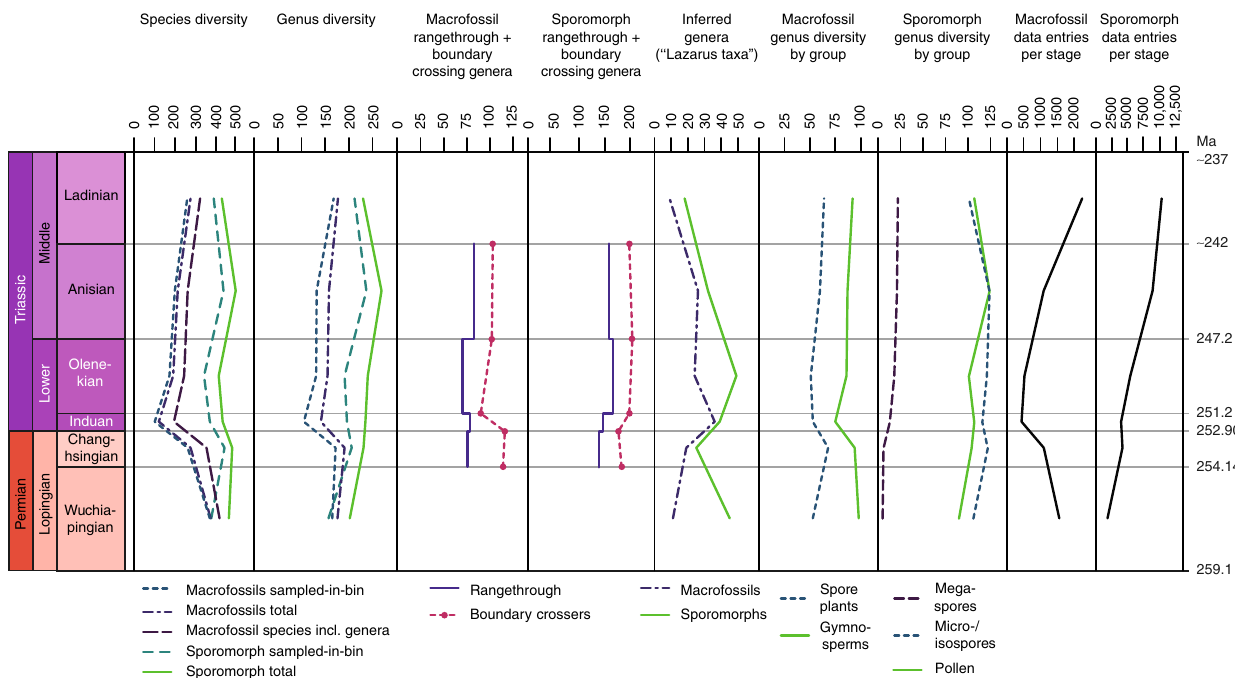
Fig. 1 Diversity indices and distribution of data entries per stage. Results for sporomorphs and plant macrofossil taxa from the Wuchiapingian to